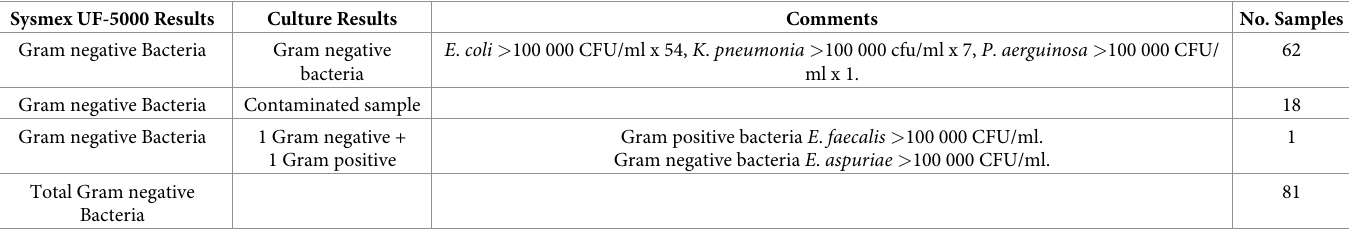
Table 5. Culture results for 81 positive samples by flowcytometry containing Gram negative bacteria. Sysmex UF-5000